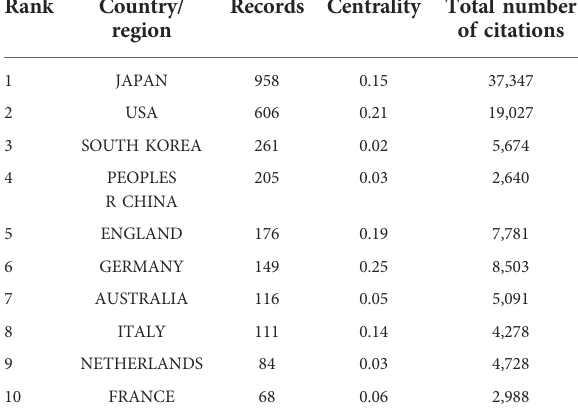
TABLE 1 Top 10 countries in terms of publications. Rank Country/